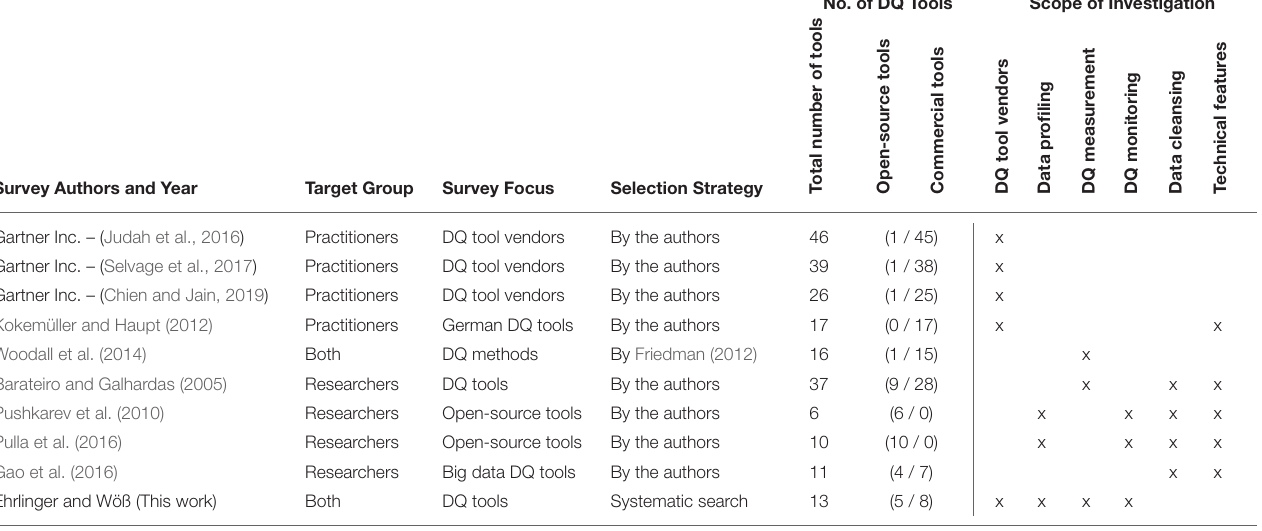
TABLE 1 | Comparison of related data quality tool